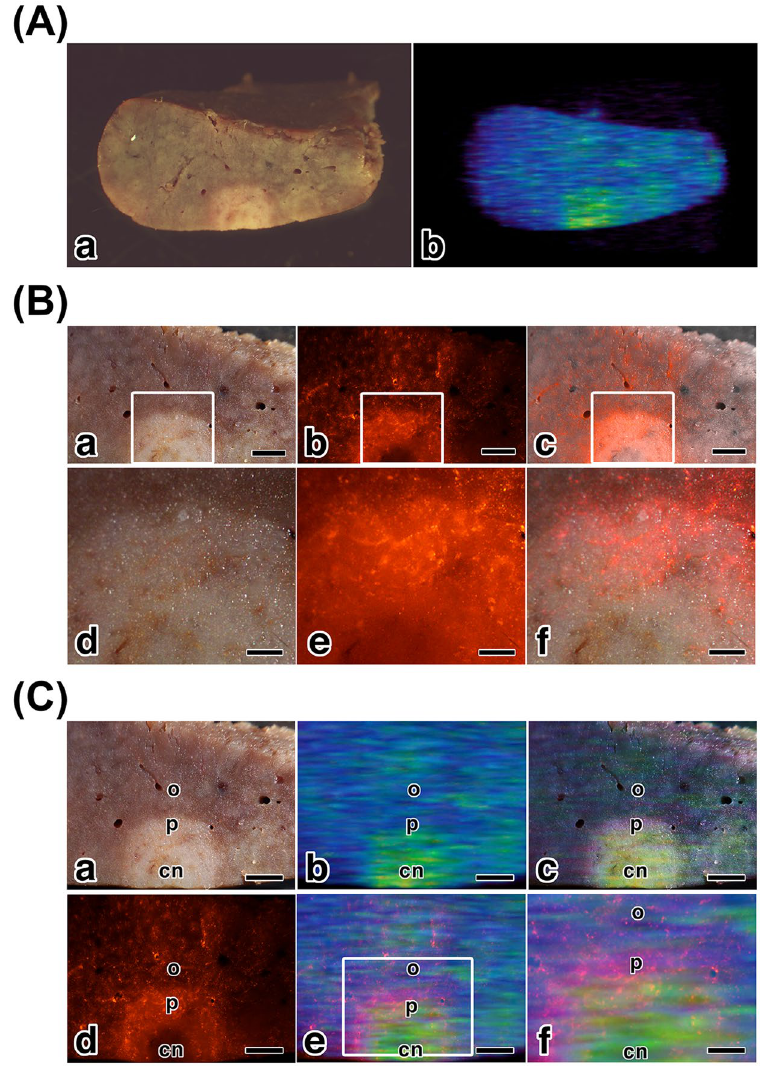
Figure 4. Mesoscopic multimodal imaging of a sectioned liver of LEC rat. ( A ) The section of the pathologic liver showed a white nodule in the bright field image (a), and in the T2-weighted MRI (b). ( B ) The peripheral area (p) of the white nodule were observed on bright field (a and d) and on FI (b and e). The merged images (c and f) showed differences in the number of labeled cells among outside (o), peripheral (p), and central (cn) area of the white nodule. Scale bars: (a–c) 1 mm, (d–f) 0.25 mm. ( C ) Correlation analysis between the FI and MRI findings of the sectioned pathological liver. Compared with the bright field image (a), the findings of the MRI (b) and the merged image (c) showed that the size of the nodular area in the MRI was smaller than that of the bright field image. The merged images of the MRI and FI demonstrated the MRI signals were surrounded by FI signal (e and f). Scale bars: (a–e) 1 mm, (f) 0.5